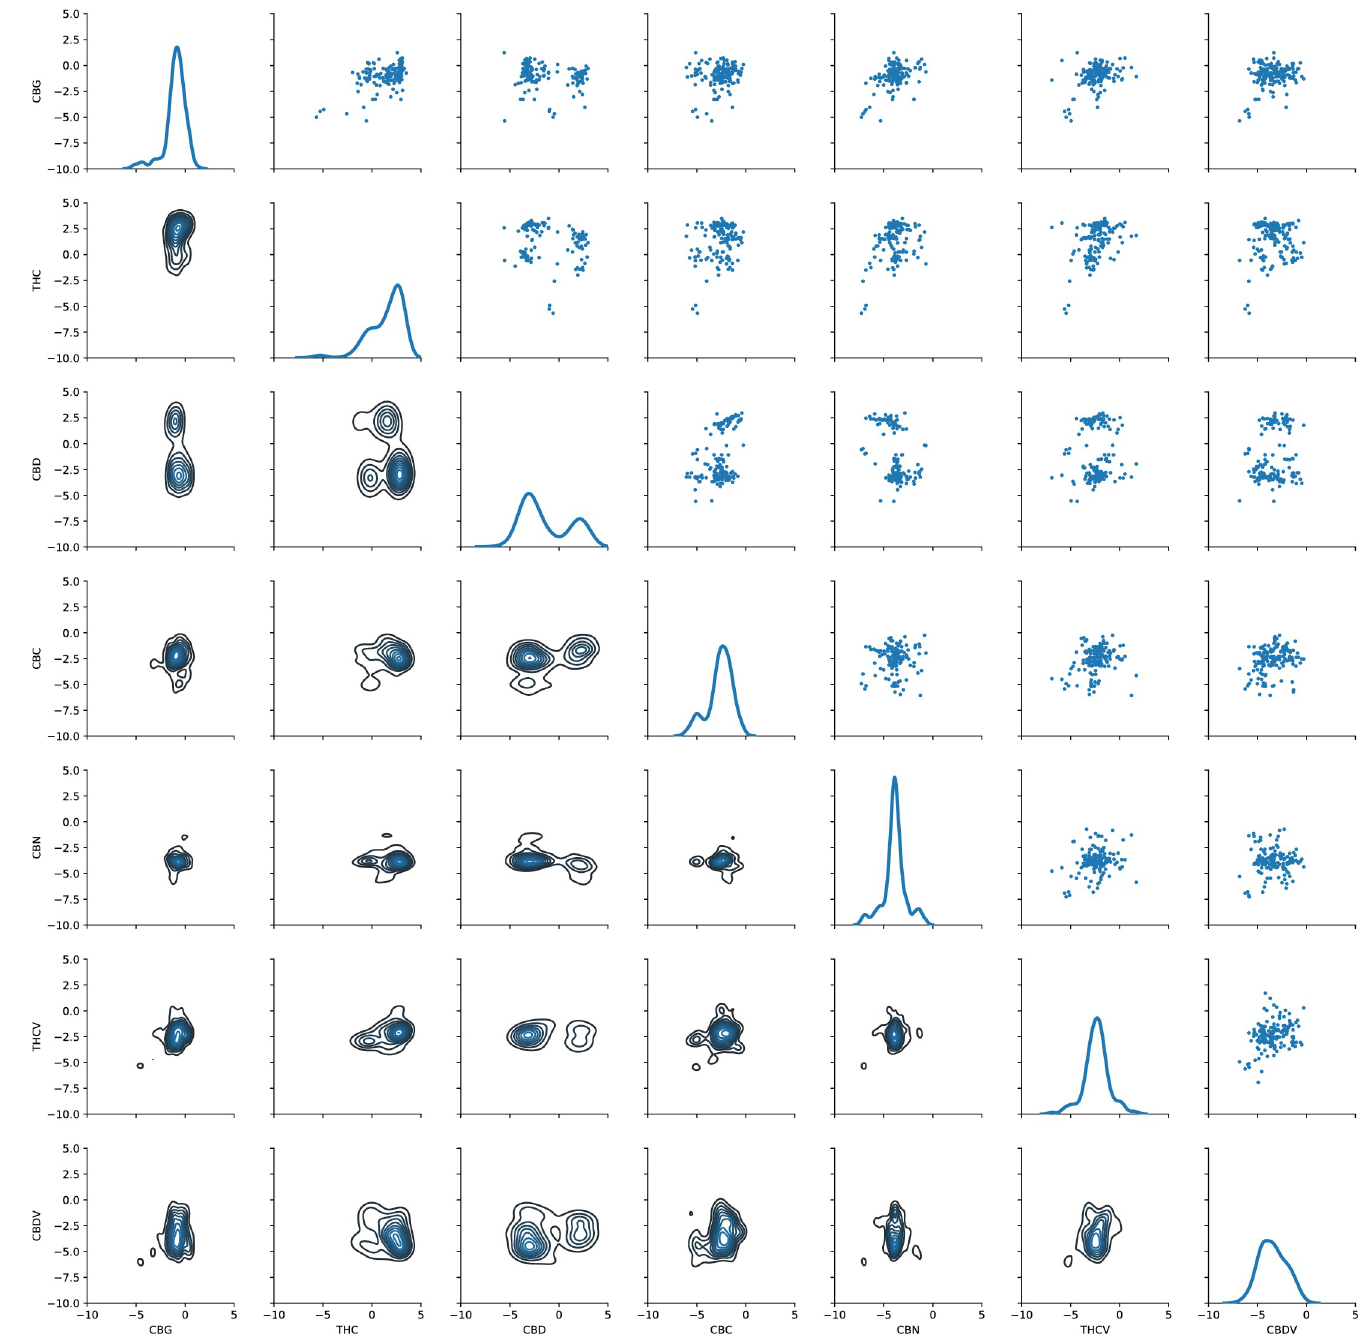
Fig 2. Pair plot of the observed distributions of (log-scaled) cannabinoids. Diagonal are kernel density estimates. Lower triangle are density plots and the upper triangle are scatter plots of the bivariate relationships. https://doi.org/10.1371/journal.pone.0236878.g002 relations between each of the seven cannabinoids against one another. The bottom triangle are density plots of the bivariate data distributions, which show distinct clusters on the common relation between each pair of cannabinoids.